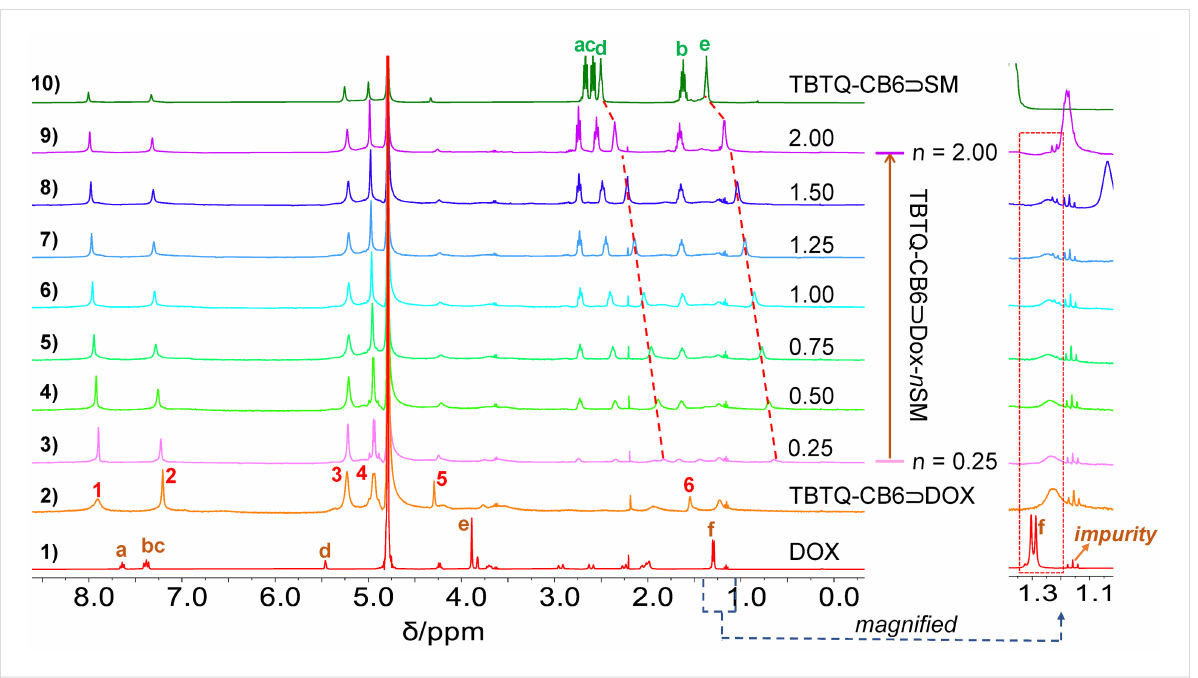
Figure 6: 1 H NMR spectra (400 MHz, D 2 O, 25 °C) of (1) DOX (3 mM), (2) TBTQ-CB6 and DOX (3 mM each), (3–9) TBTQ-CB6 and DOX (3 mM each) with gradual addition of SM , (10) TBTQ-CB6 and SM (3.0 mM